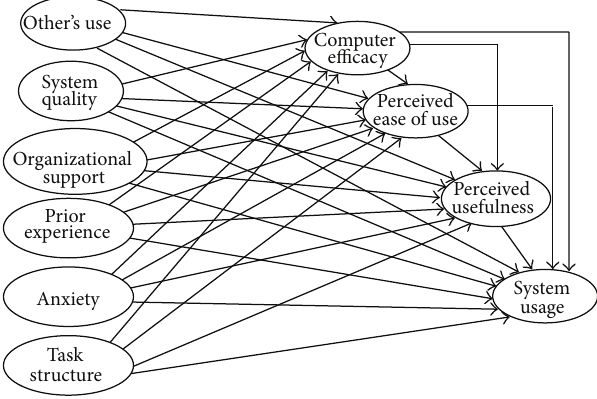
Figure 2: McFarland and Hamilton model